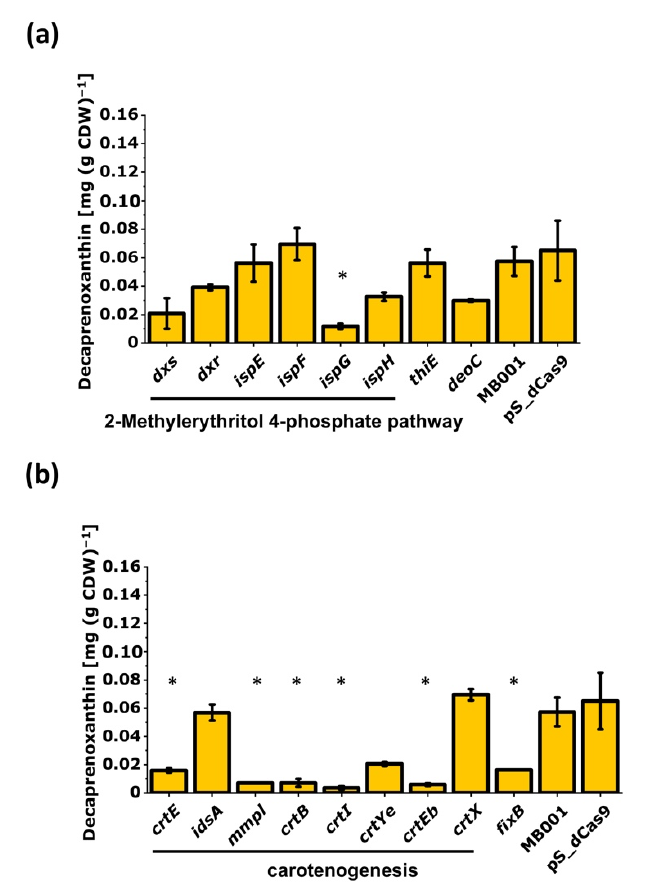
Figure 5. Influence of CRISPRi-mediated repression of genes of the MEP pathway ( a ) or of carotenogenesis ( b ) on decaprenoxanthin production by C. glutamicum . In addition, thiE , deoC , and fixB were analyzed. Mean values of biological duplicates are given. Statistical analysis was calculated with ANOVA against all measured decaprenoxanthin production of C. glutamicum MB001 from all Biolector ® flowerplates and is marked by a star (*). As a reference, the decaprenoxanthin production of the empty vector strain C. glutamicum MB001 (pS_dCas9) in biological duplicates of the corresponding experiment is shown. For abbreviations, see Figure 3.